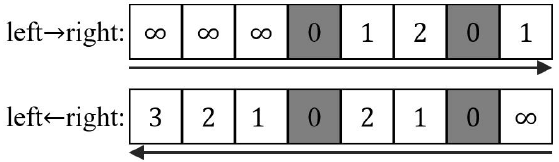
Figure 4. An Example of Step